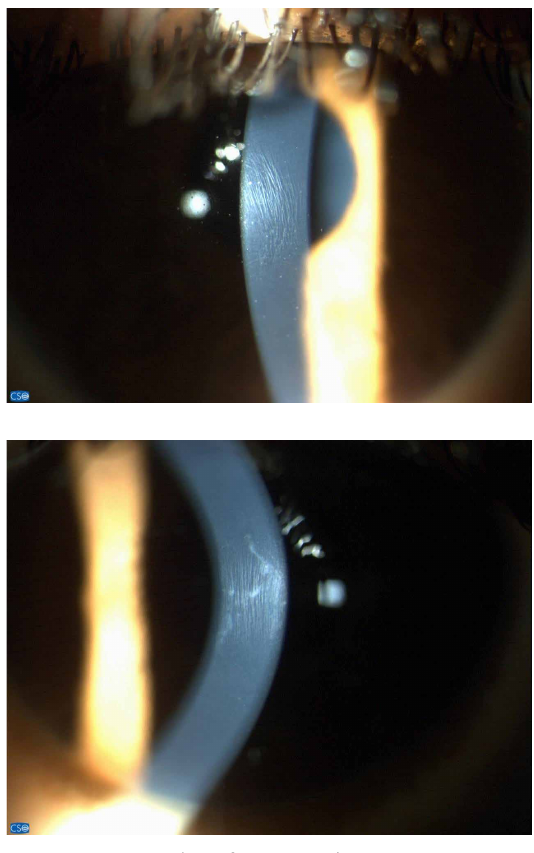
Figure 7 . Examples of Vogt’s striae.